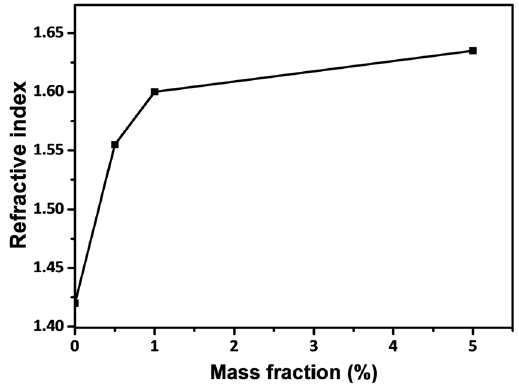
Figure 5. RI of S-TiO 2 /silicone nanocomposites with different mass